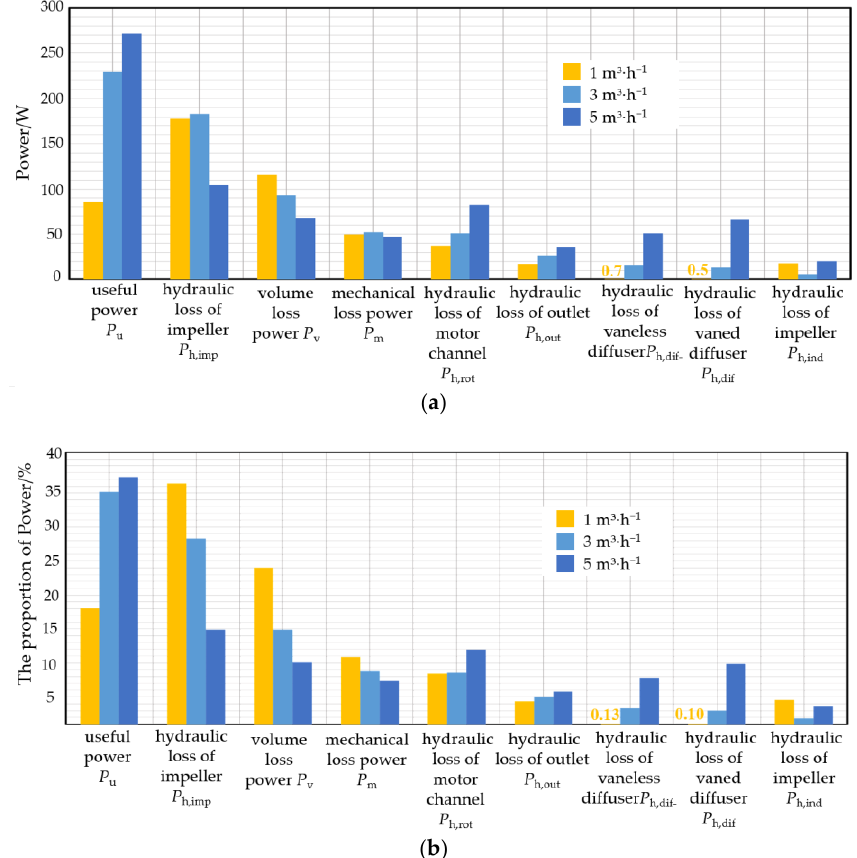
Figure 9. Various lost power under different flows. ( a ) Energy loss power; ( b ) proportion of energy loss power.